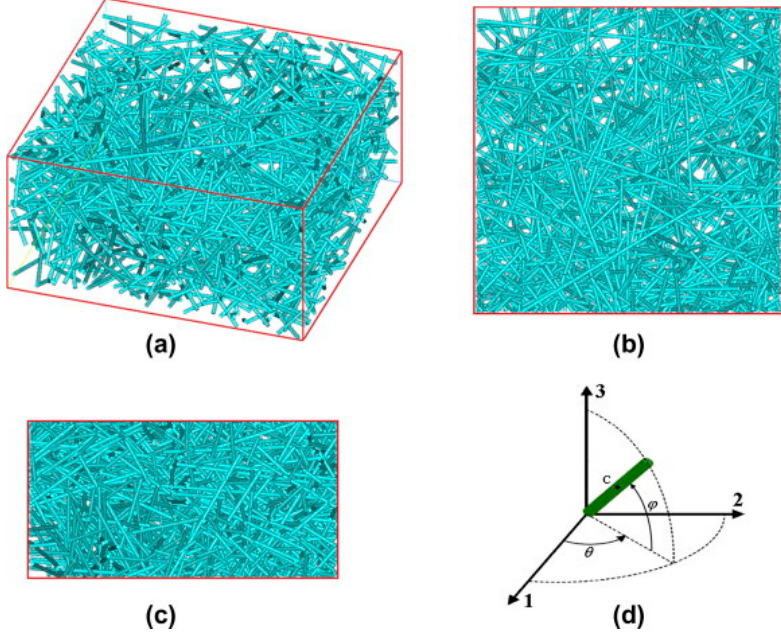
Figure 10. The sketch for the fiber architectures in the 3D model, ( a ) overall spatial view, ( b ) top vie, ( c ) side view, and ( d ) a fiber is described by the center point C, and two Euler angles θ and φ . Reproduced with permission [50].